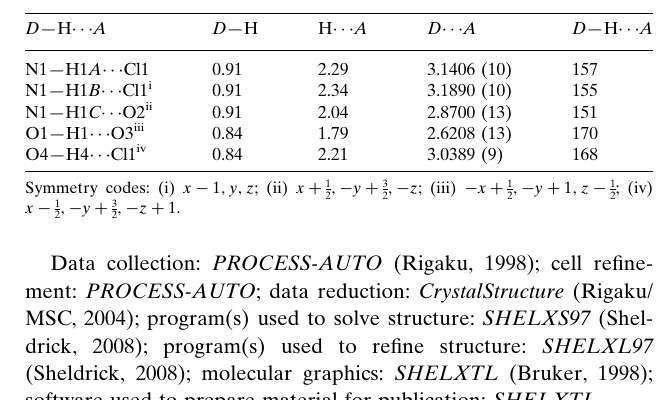
Hydrogen-bond geometry (A˚ , (cid:4)